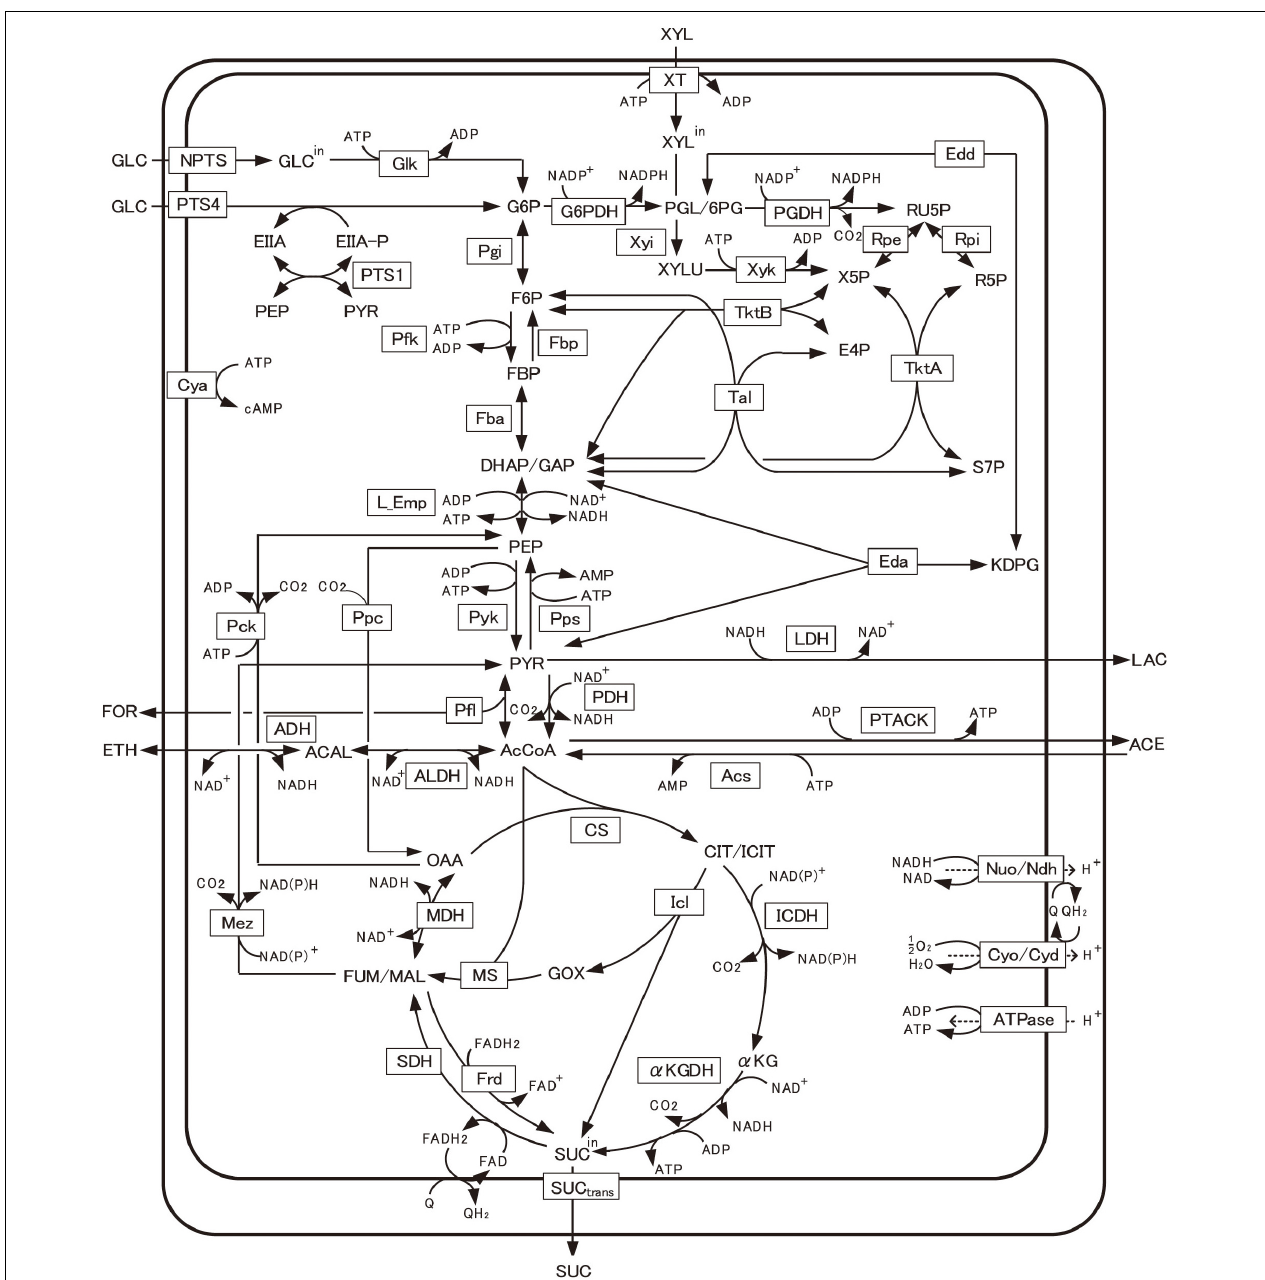
FIGURE 1 | Main metabolic pathways in Escherichia coli . The present model includes glycolysis, TCA cycle, respiratory chain, pentose phosphate (PP), gluconeogenic, glyoxylate, anaplerotic, fermentative, and xylose assimilating pathways, as well as the glucose transport system of phosphotransferase system (PTS) and xylose transport (XT). The full name of the metabolite and enzyme is given in Nomenclature. Transcriptional regulations are given in Supplementary Table S1